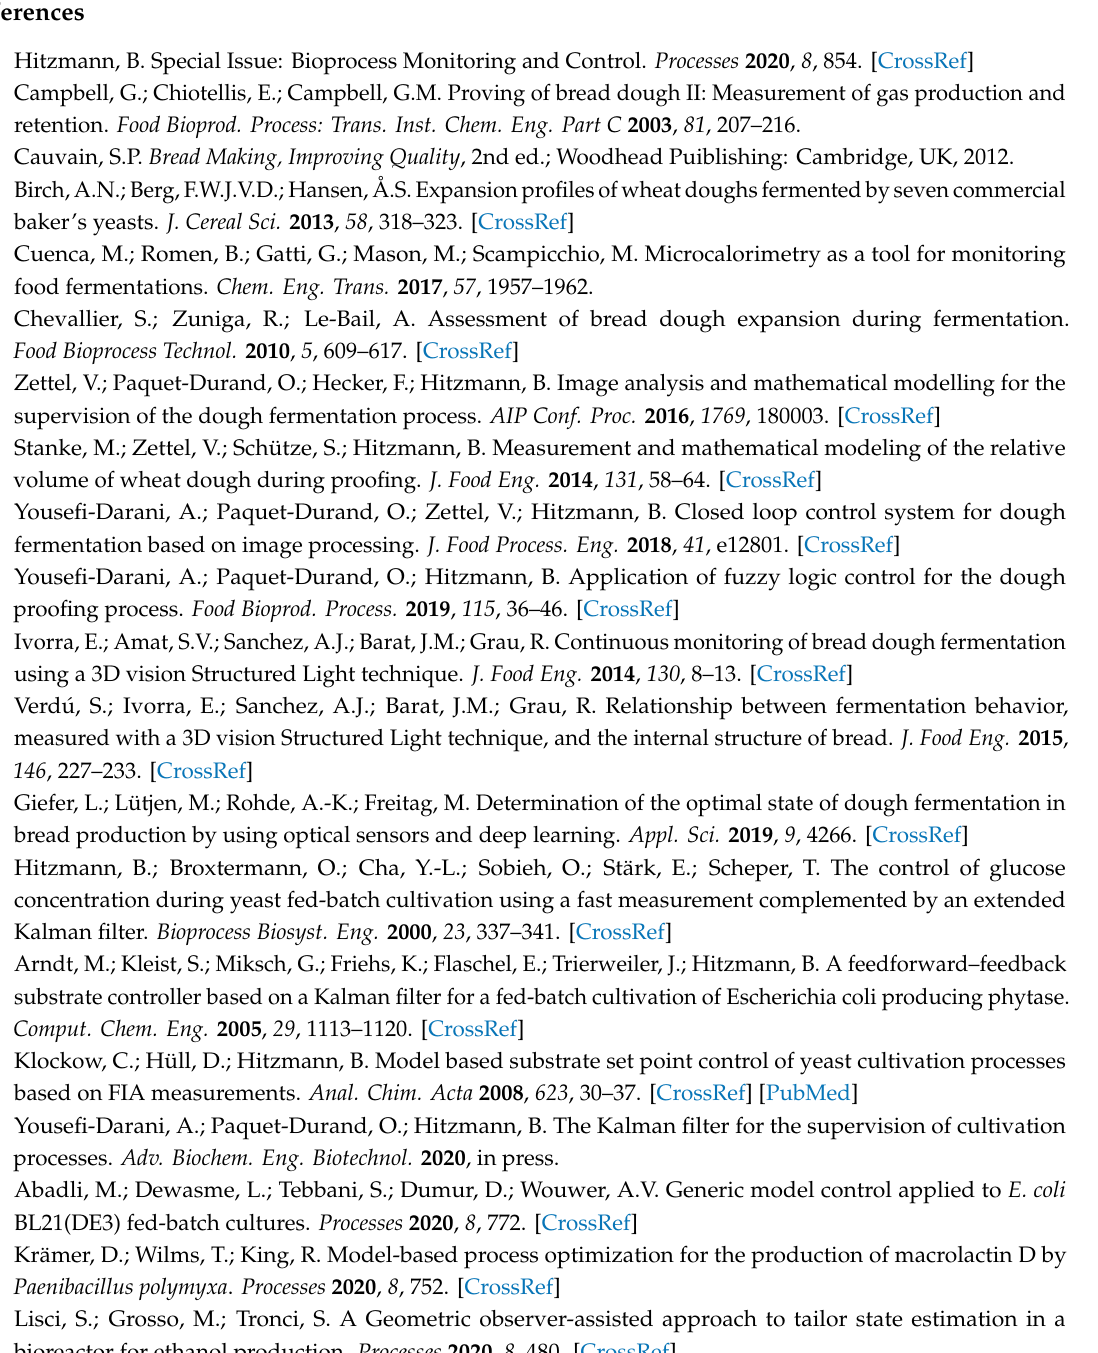
Table S1: Measurements used for the extended Kalman